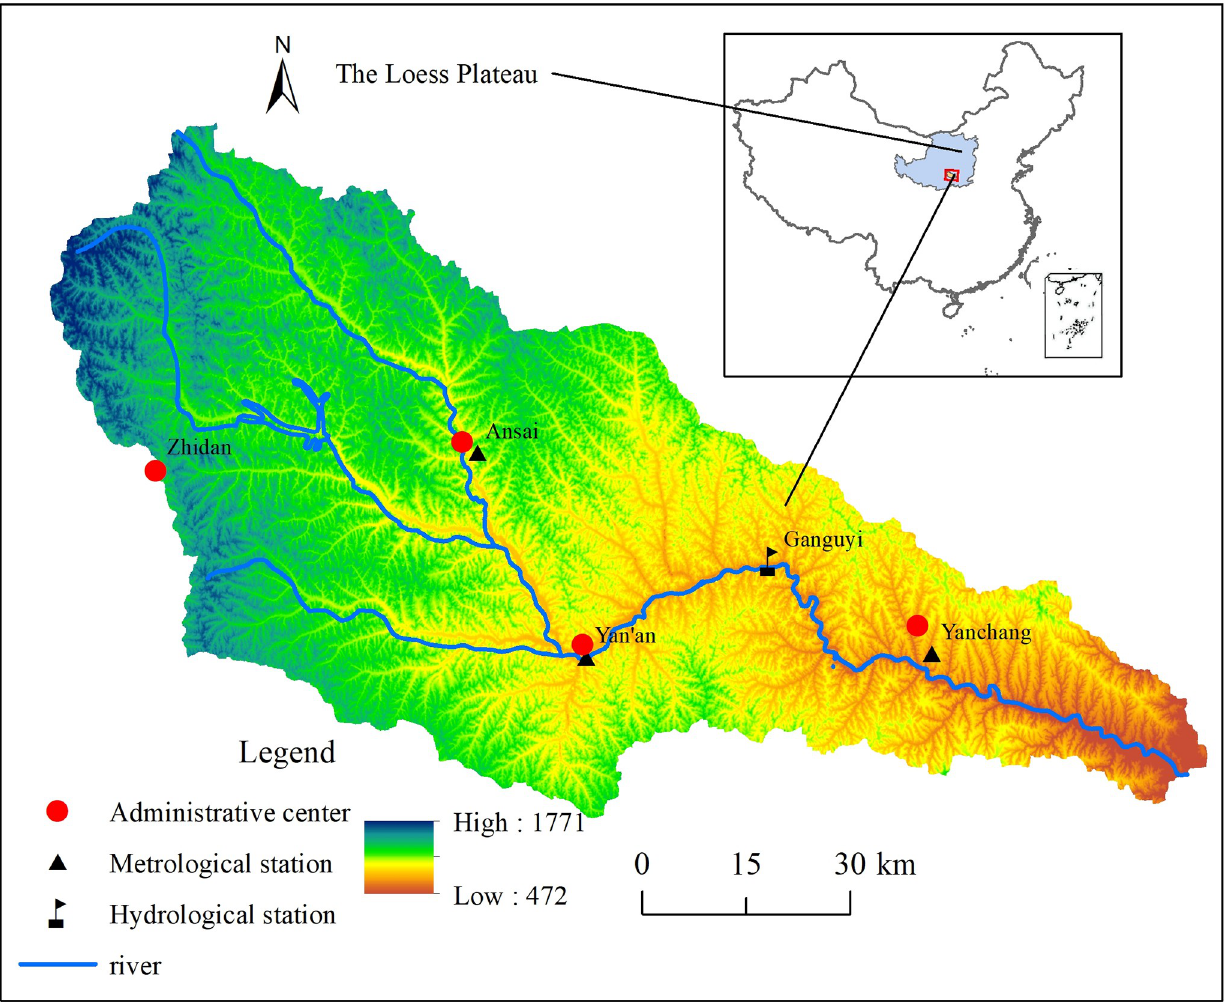
Fig 1. Location and distribution of the hydrological and meteorological stations in the Yanhe River Basin. Yanhe river watershed (right; red square) in China, meteorological station locations marked by black triangles. The blue line indicate yanhe river. Red dots indicate administrative center and black flag indicate hydrologic station. The Yanhe river catchment (left) and elevation range. Digital elevation model data source: the Geospatial Data Cloud (http:// www.gscloud.cn/). The map was prepared in ARCGIS using basin boundaries from the China Database of Topographic map.